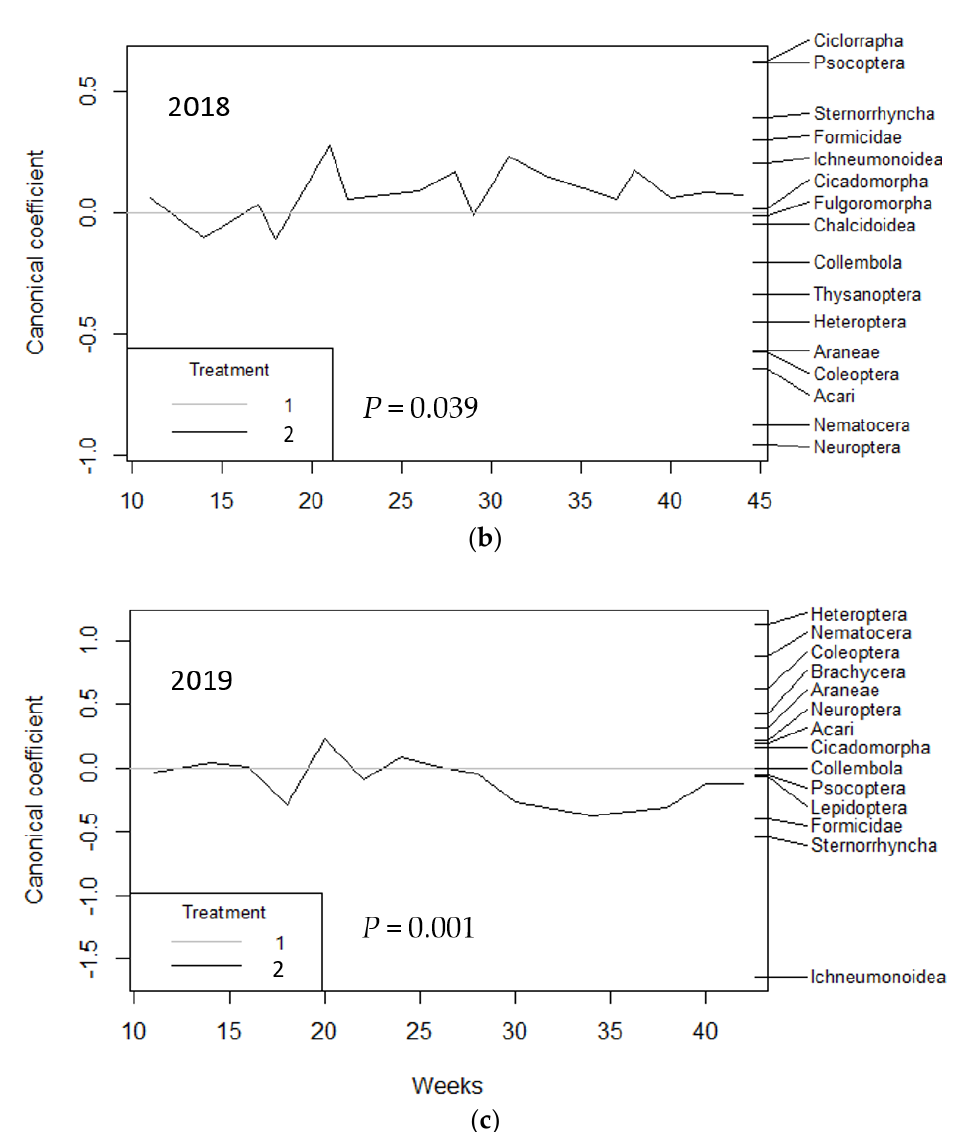
Figure 1. Principal response curves (PRC) of the most important arthropods taxa in the vacuum sampling for ( a ) 2017, ( b ) 2018, and ( c ) 2019. The p values denote the significance of treatment T2 (Confederation RDI), represented as a plotted line, relative to the control treatment T1 (control) over all dates based on an F-type permutation test. The taxonomic groups are showed in the right vertical axis with their weights, which have the same scale as the canonical coefficients on the left vertical axis.